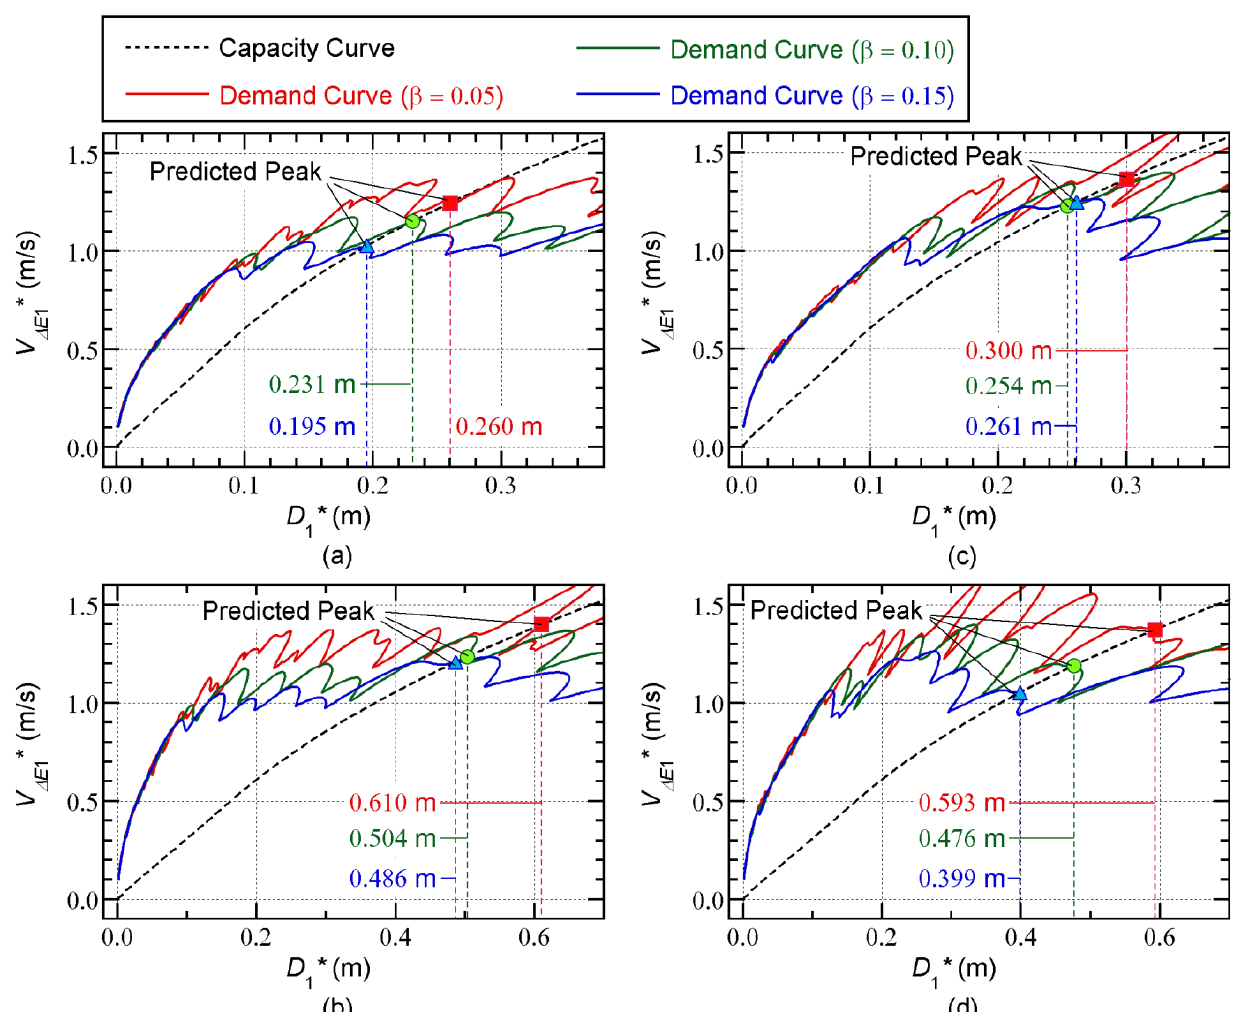
Figure 8. Prediction of the peak response point ( h 1 f = 0.05): ( a ) 8-story model (Art-L series); ( b ) 16-story model (Art-L series); ( c ) 8-story model (Art-S series); ( d ) 16-story model (Art-S